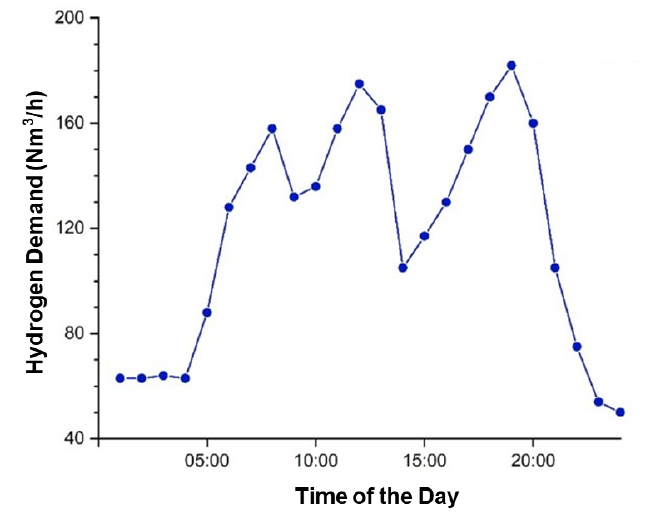
Figure 3. Curve of hydrogen demand in system.